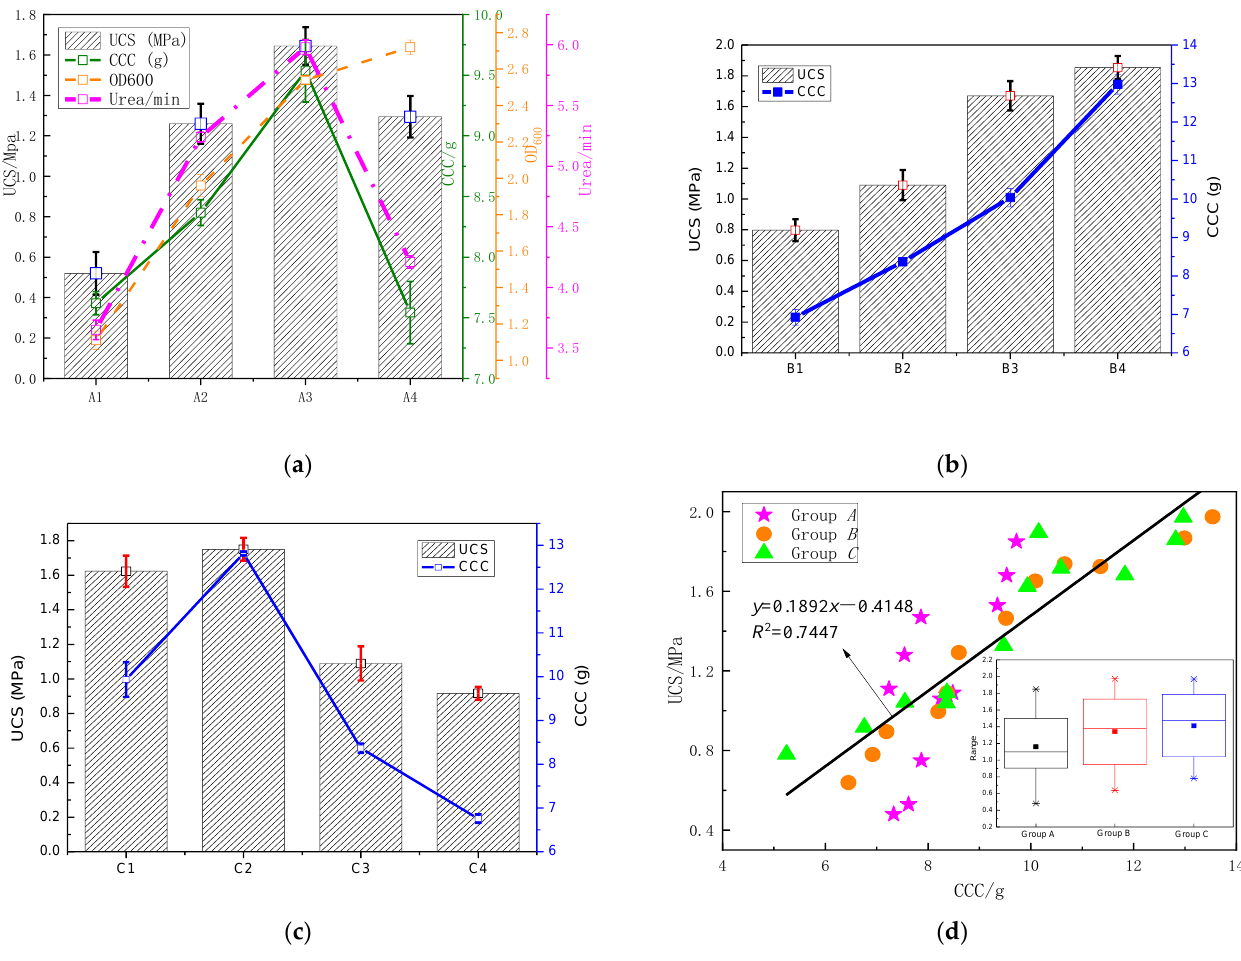
Figure 8. Relationship between UCS and CCC of MSDF. ( a ) Group A, ( b ) Group B, ( c ) Group C, ( d ) Relationship between UCS and CCC